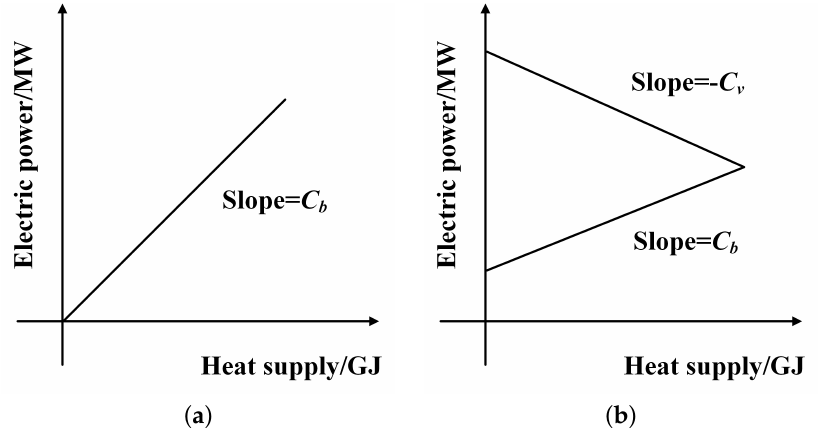
Figure 4. The relationship between electric power and heat suuply of different types of units. ( a ) Back pressure turbine. ( b ) Pumping